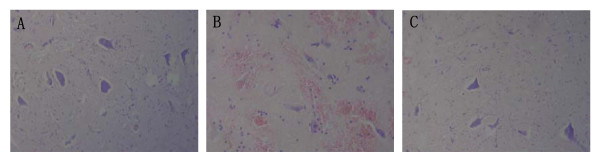
Spinal cord histopathology following I/R. Rabbits were treated with vehicle (saline) or TMP (30 mg/kg) prior to the onset of ischemia (30 min), followed by 48 h of reperfusion. Sham animals received the same pretreatment as I/R group, followed by sham operation. The ischemic spinal cord sections were prepared and stained with H&E. Figure A represent the sham rabbits, which show normal histology. Figure B represent control rabbits, which show a pattern of necrotic changes with karyolysis and neurophil vacuolation. Figure C represent TMP- treated rabbits, which show mild degrees of destruction such as triangular shape, and Nissl granule loss in some motor neurons. Figures(magnification × 200) are representative of 3 separate experiments with similar results.